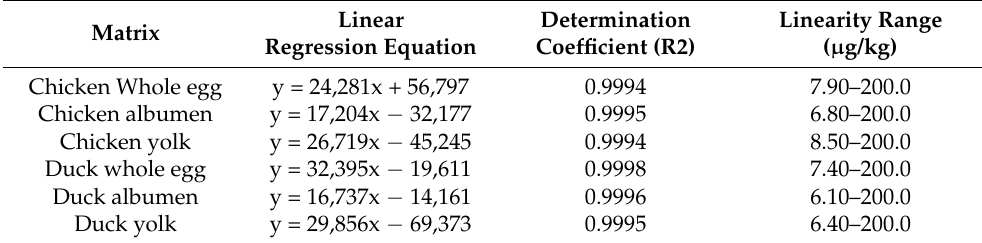
Figure 2. Effect of the amount of TMSD ( A ), derivatization temperature ( B ), and derivatization time ( C ) on the derivatization reaction and the stability of the penicillin G derivative within 24 h ( D ). Table 3. Linear regression equations, determination coefficients and linearity ranges of penicillin G in poultry eggs ( n =